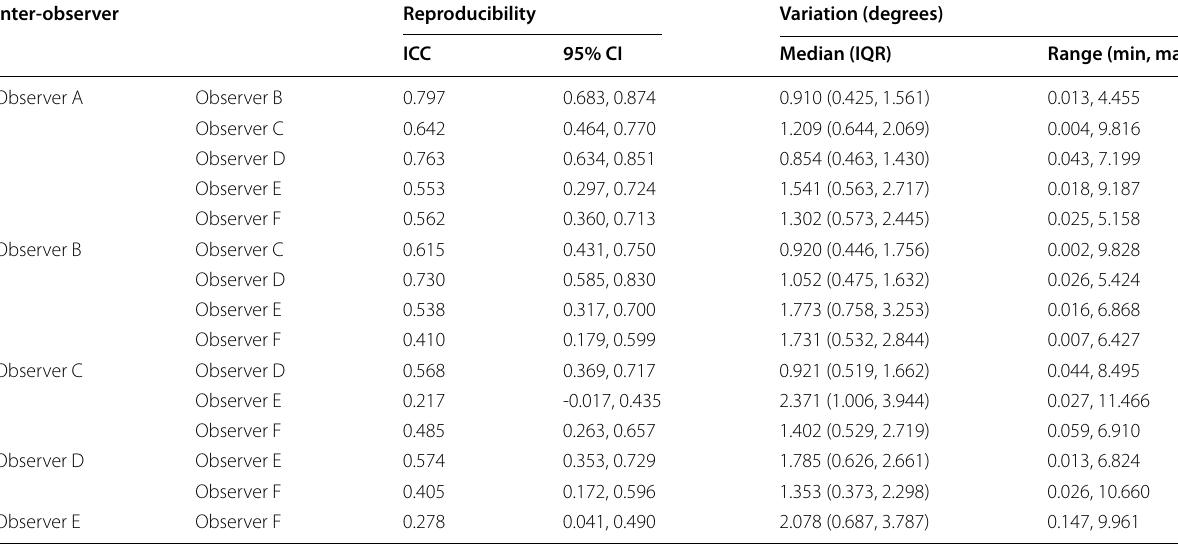
Table 2 Inter-observer reproducibility and variation